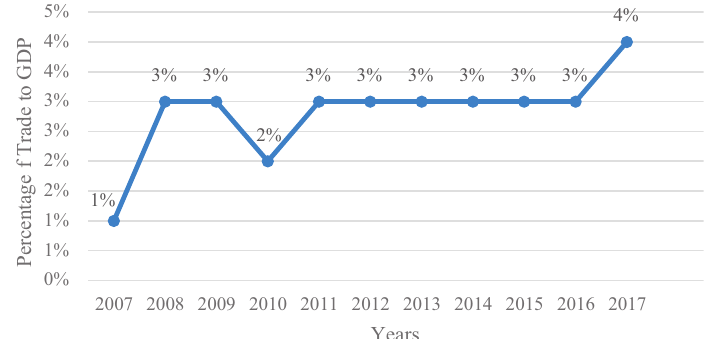
Figure 1. Egypt – China trade-to- GDP-ratio from 2007 until 2017